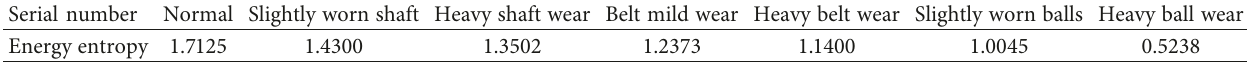
Table 6: The energy entropy distribution of the second category failure mode (rotation shaft, belt, and ball).